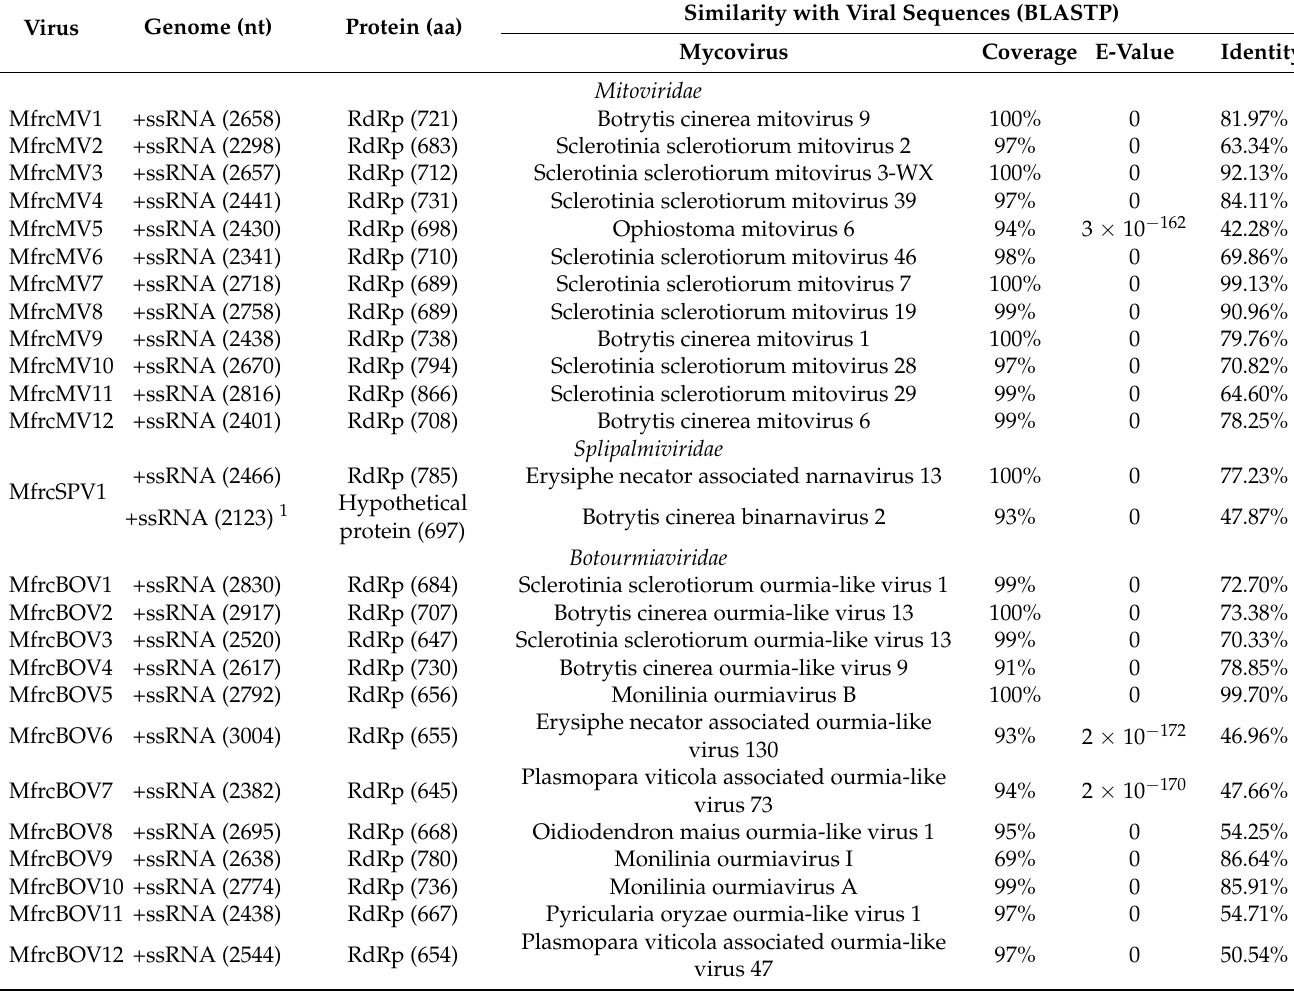
Table 4. Putative mycoviruses identified in Monilinia fructicola